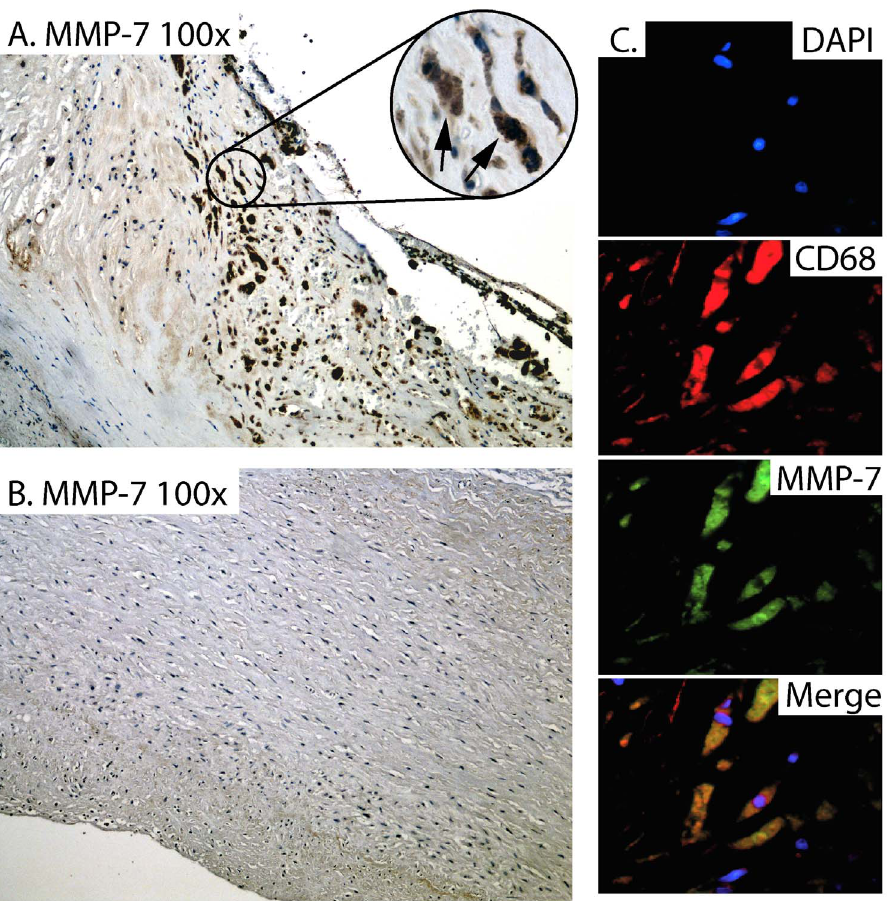
Figure 3. Immunostaining of MMP-7 within atherosclerotic and non-atherosclerotic vessels. Immuhistochemistry of MMP-7 in carotid atherosclerotic plaques (n=8, symptoms within the recent 2 months) shows strong immunostaining. Representative images obtained with 100 6 A and 400 6 magnification (highlighted, with arrows on positive cells). Panel B shows no or weak immunostaining of MMP-7 in non-atherosclerotic carotid artery obtained from autopsies (n=5). Panel C shows double immunofluorescent staining of MMP-7 (green fluorescence), CD68 (macrophages, red fluorescence) and nucleus (DAPI, blue fluorescence) from carotid atherosclerotic plaques (n=4). The lower right panel is a merge of the three